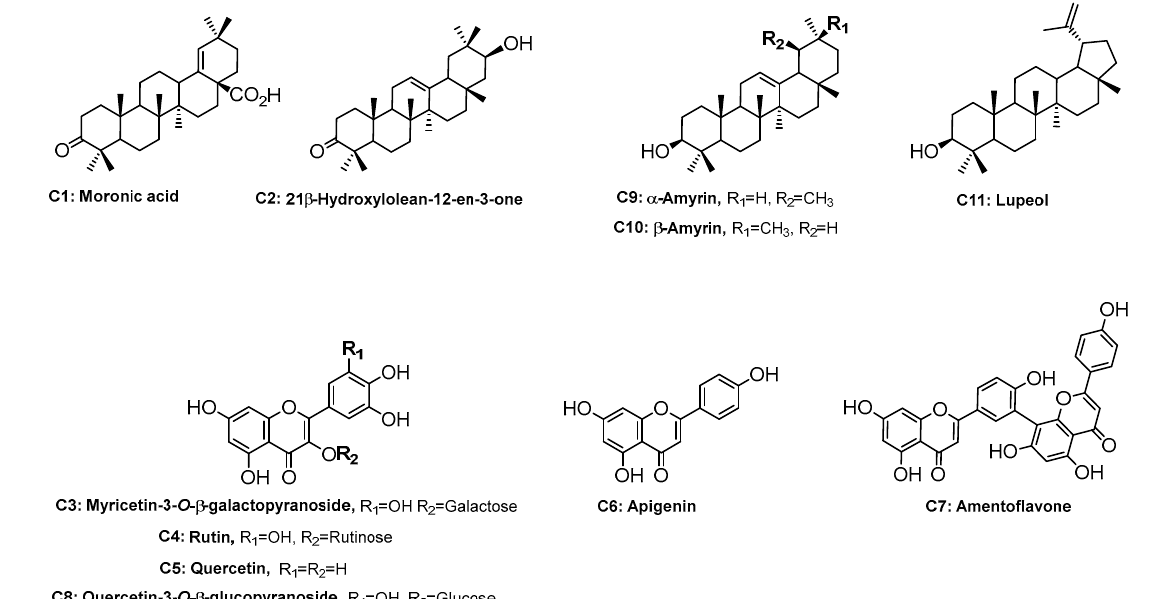
Figure 1. Chemical structures of the isolated compounds ( 1 – 11 ) from S. gluaca, S. lucida , and S. laevigata.